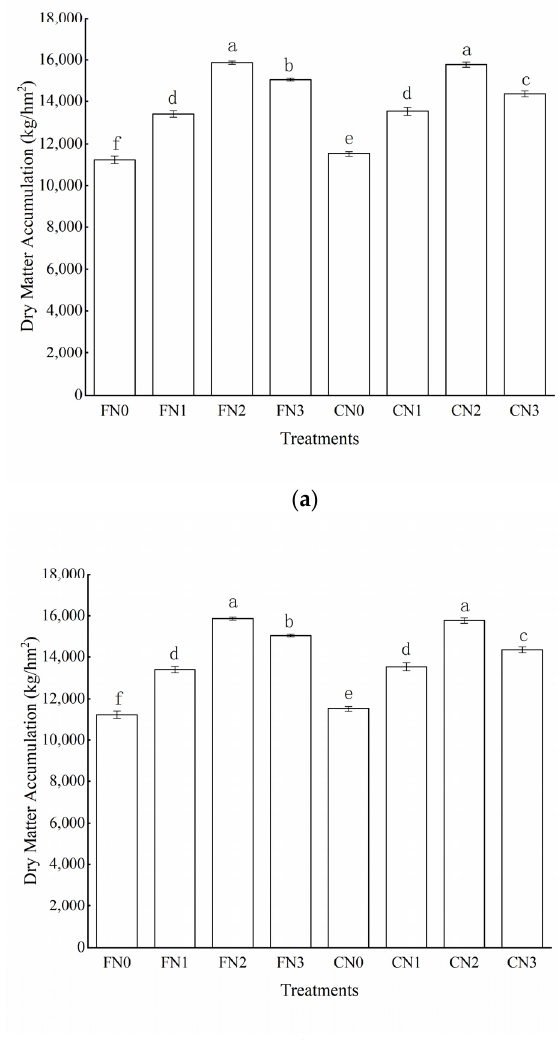
Figure 1. Dry matter accumulation under the different water and nitrogen treatments in ( a ) 2019 and ( b ) 2020. Note: the different letters in the same figure indicate that the difference between treat- ments was significant ( p < 0.05), and the same letter indicates that the difference was not significant ( p > 0.05), same as below.